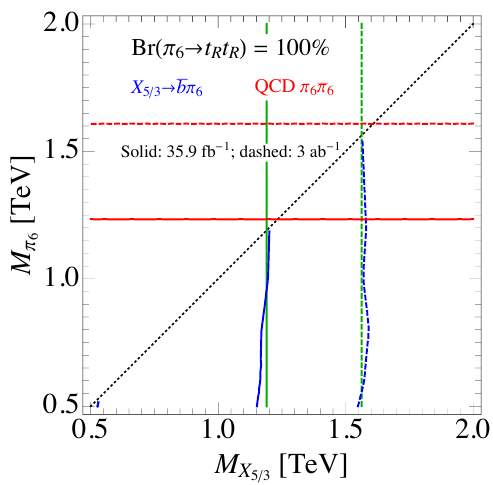
Figure 2 . Bounds on the M X { M (cid:25) plane from the CMS SSL search of ref. [10] (solid lines) 6 5 = 3 and projections for the HL-LHC reach (dashed lines) for the exotic decay X the QCD pair produced sextets (red). The bounds and projections for the standard Br( X tW + ) = 1 decay are shown for reference in green. The horizontal red lines show the bound from the direct QCD pair production of the sextets derived from the same SSL search [10]. The bounds become insensitive to M (cid:25) for light masses above 6